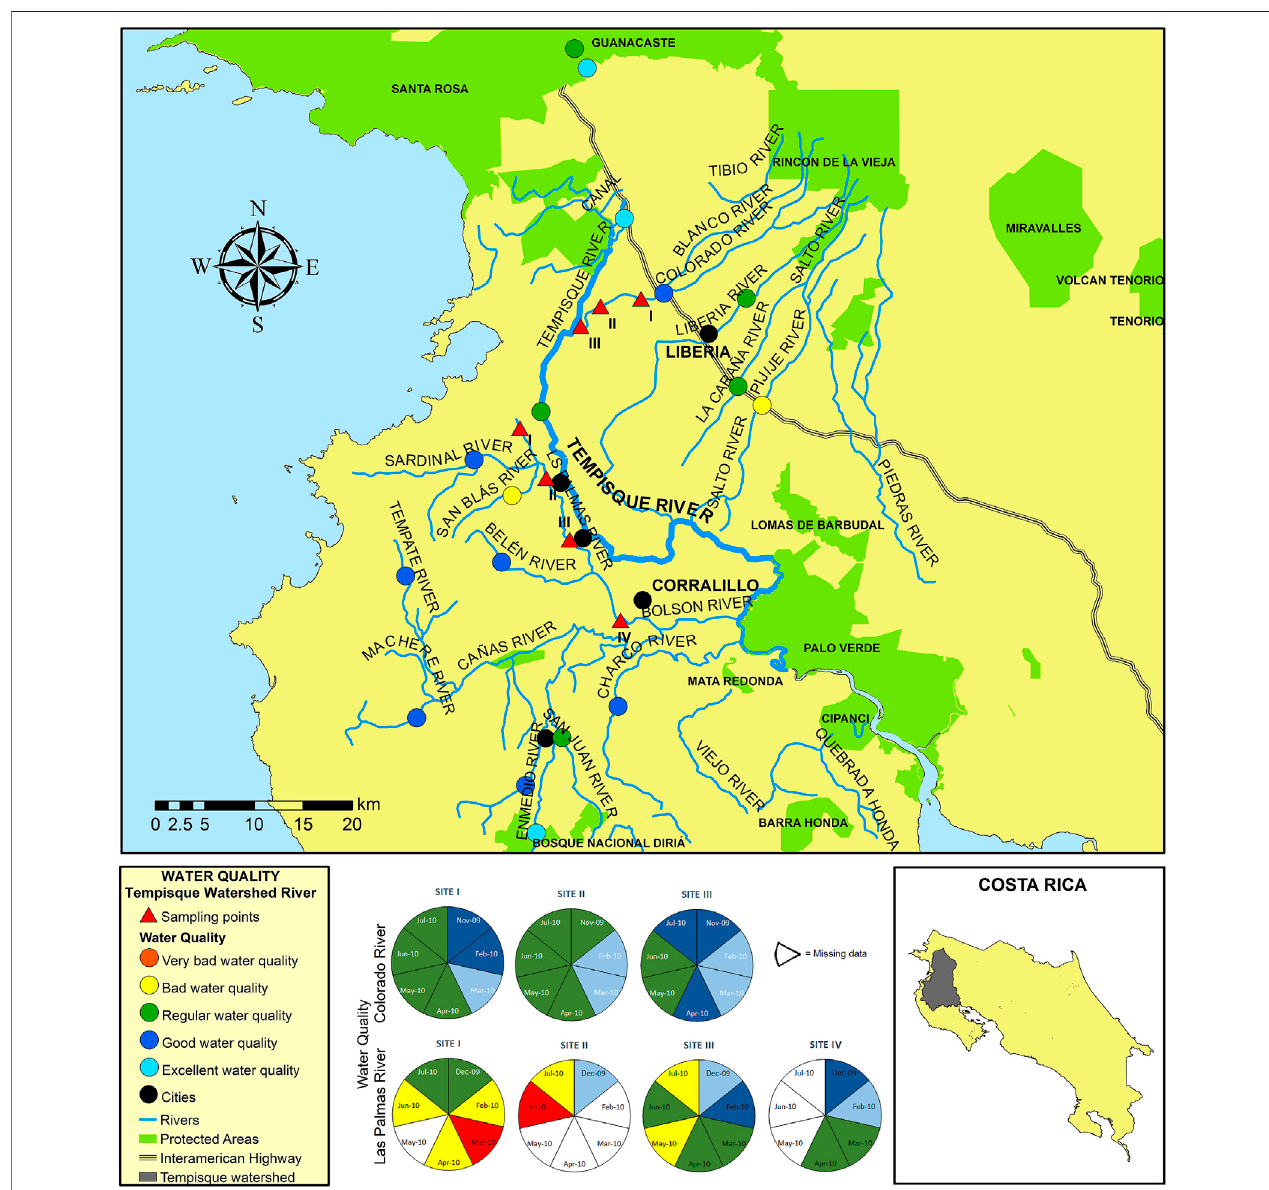
FIGURE 7 | Map showing the BMWP ′ -CR values found at different localities in the Tempisque Basin.